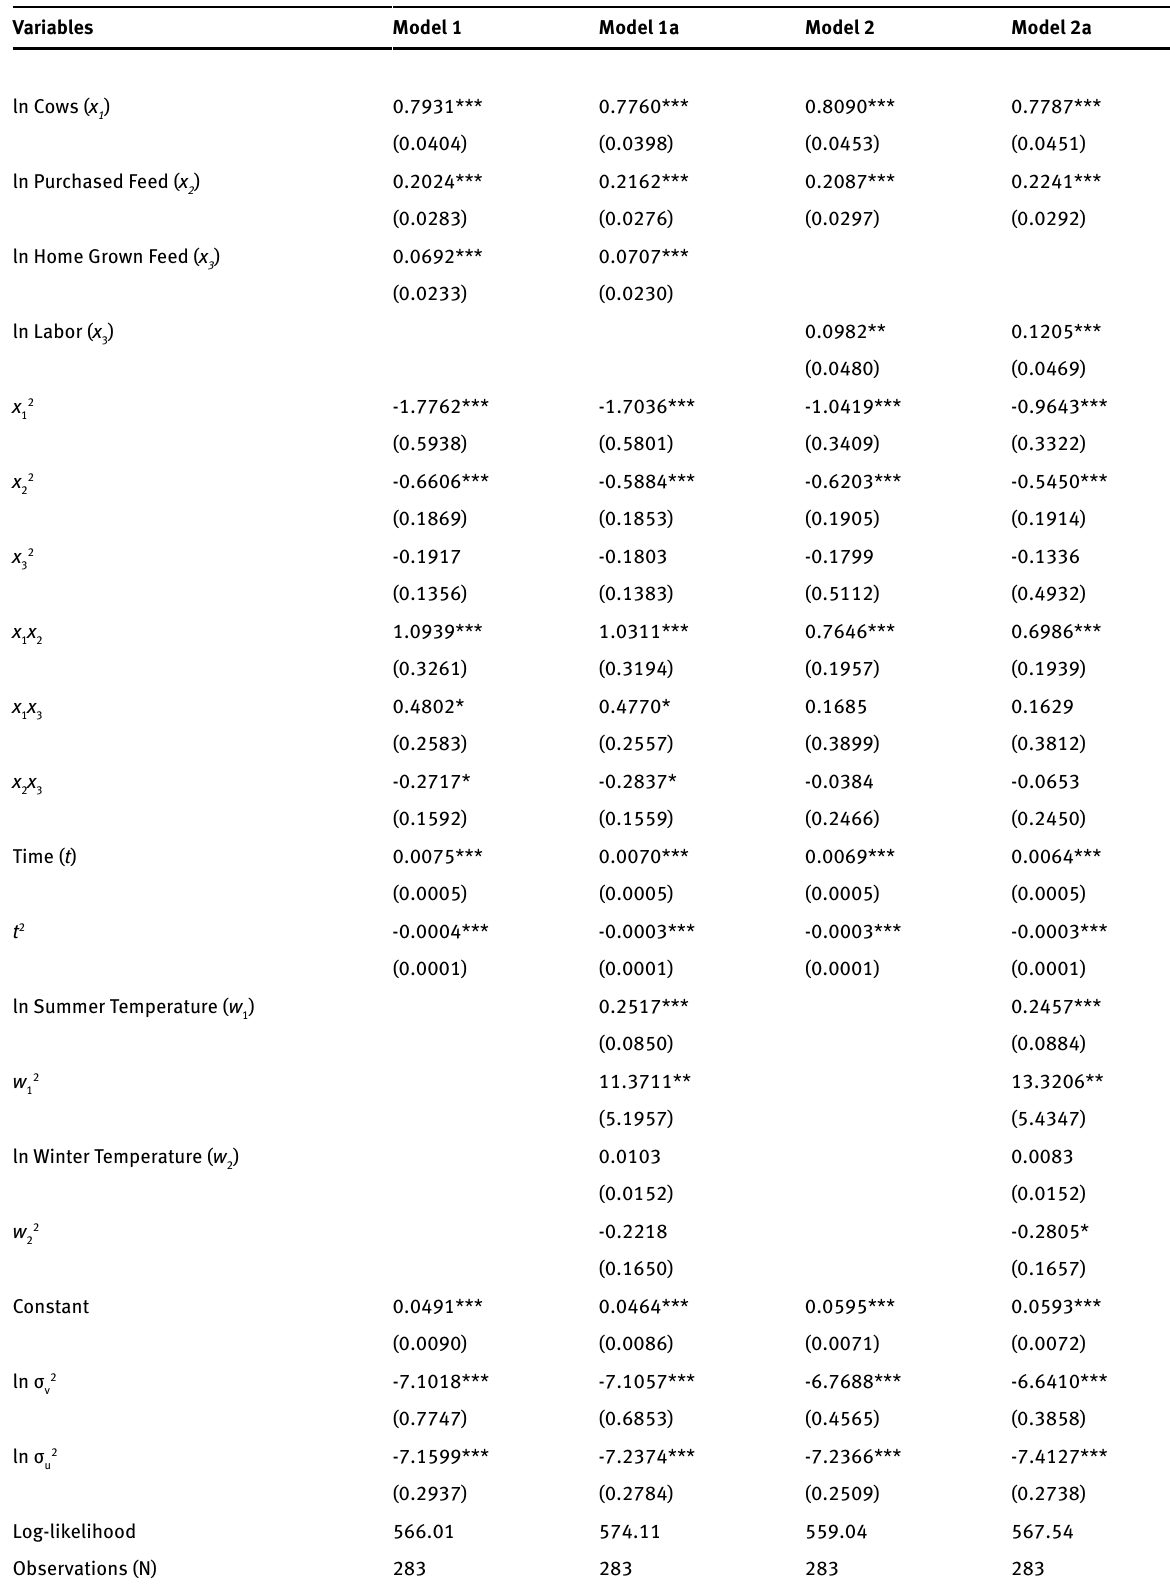
Table 3: Estimates from stochastic production frontier